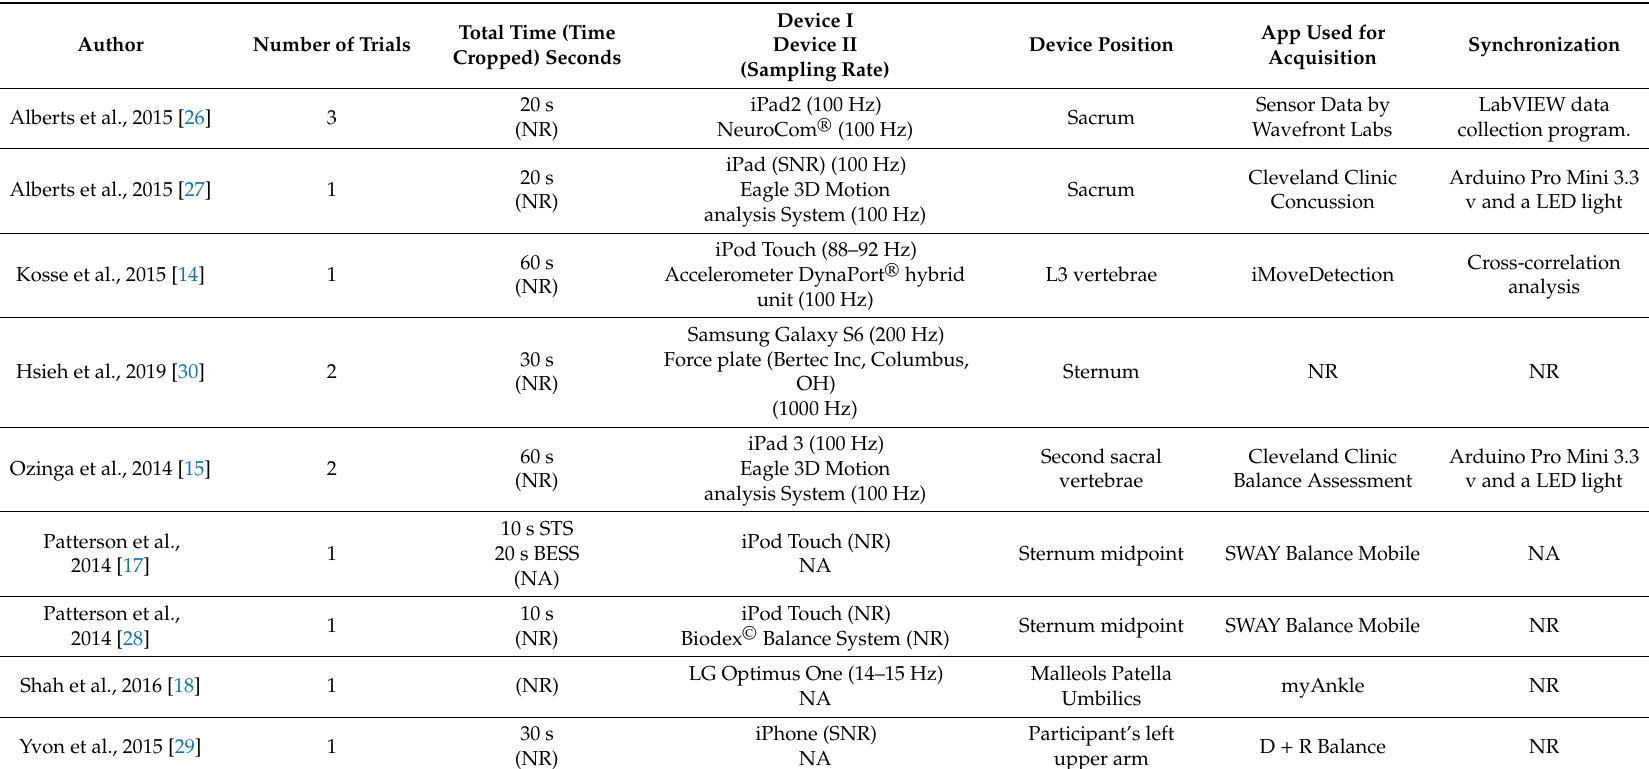
Table 3. Balance protocol procedures, devices and technical